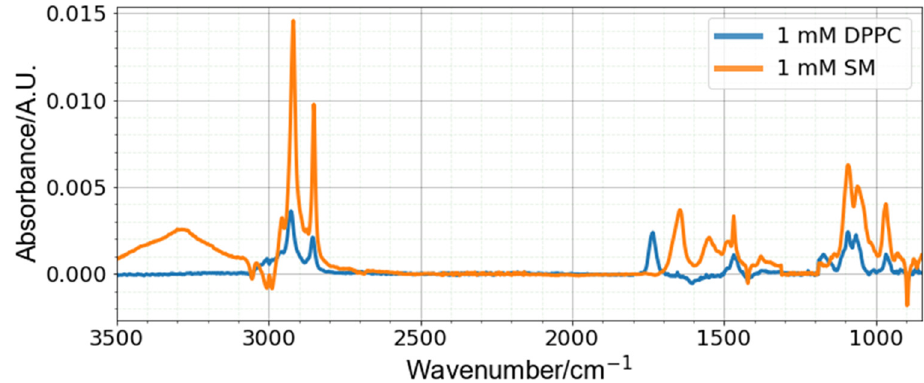
Figure 1. Spectra of DPPC and SM—spectra free of water vapor interference shown.